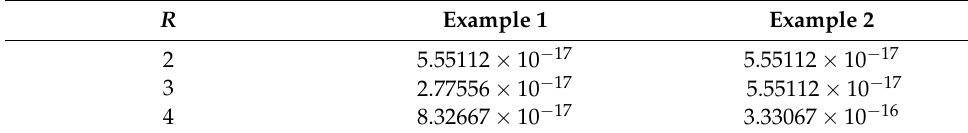
Table 1. MAE of Example 1 and Example 2 for different values of R .